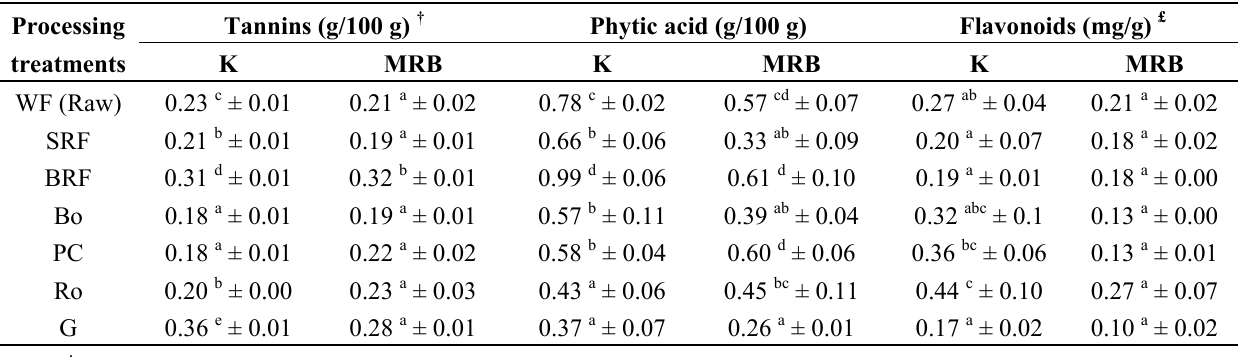
Table 2. Effect of processing on antioxidant components of pearl